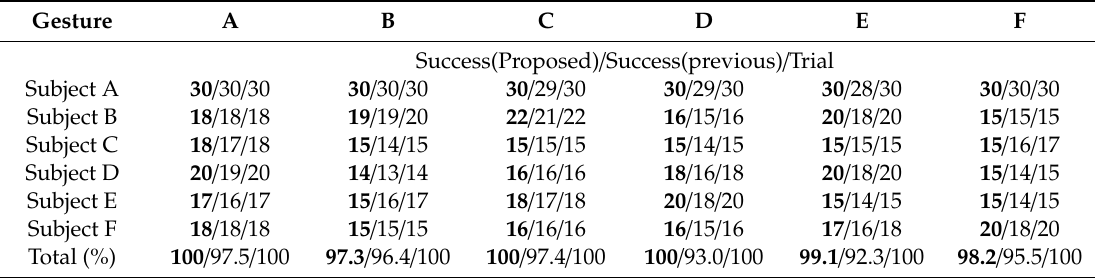
Figure 12. The six gestures that were defined in Jung’s research. Table 1. Comparison results for each subject.